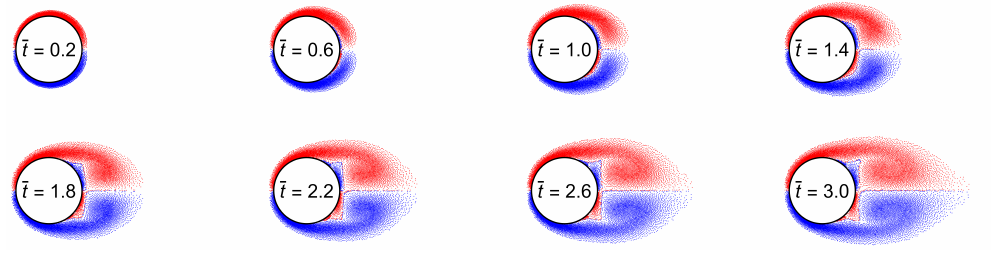
Figure 5. Symmetric vortex wake development after the impulsively started cylinder up to dimen- sionless time ¯ t = tV ∞ / D = 3.0; Re = 200.